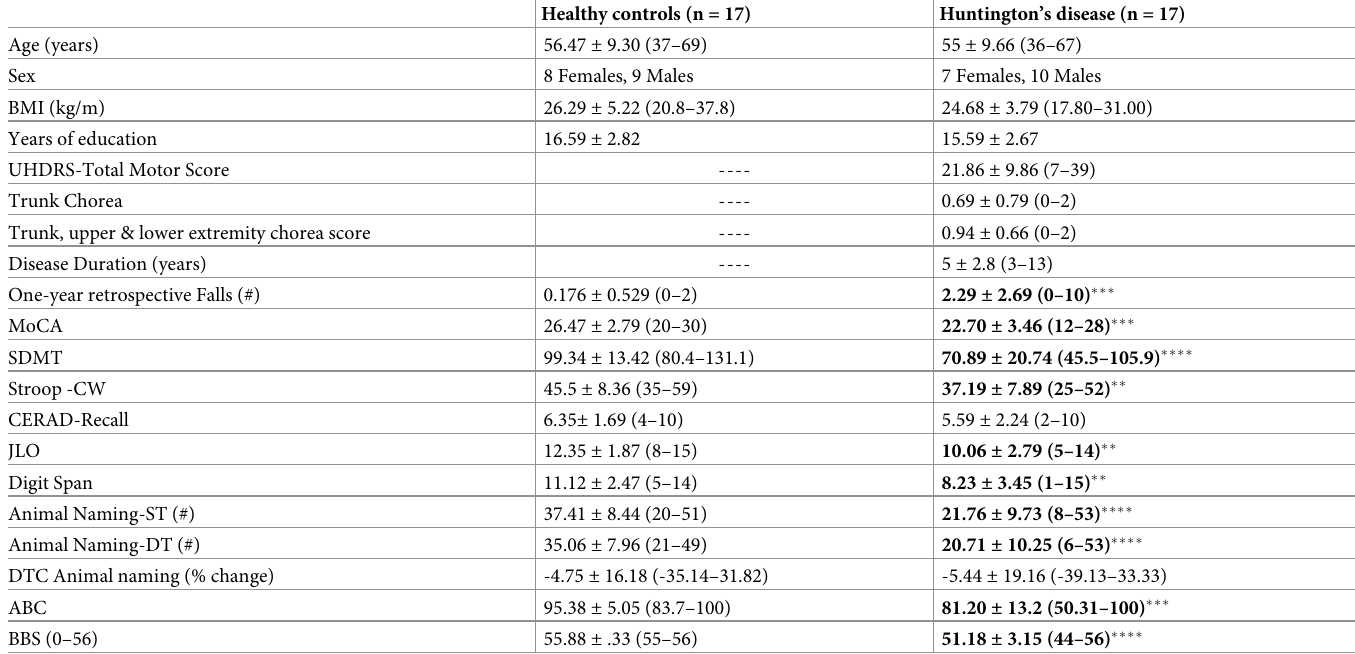
Table 1. Subject